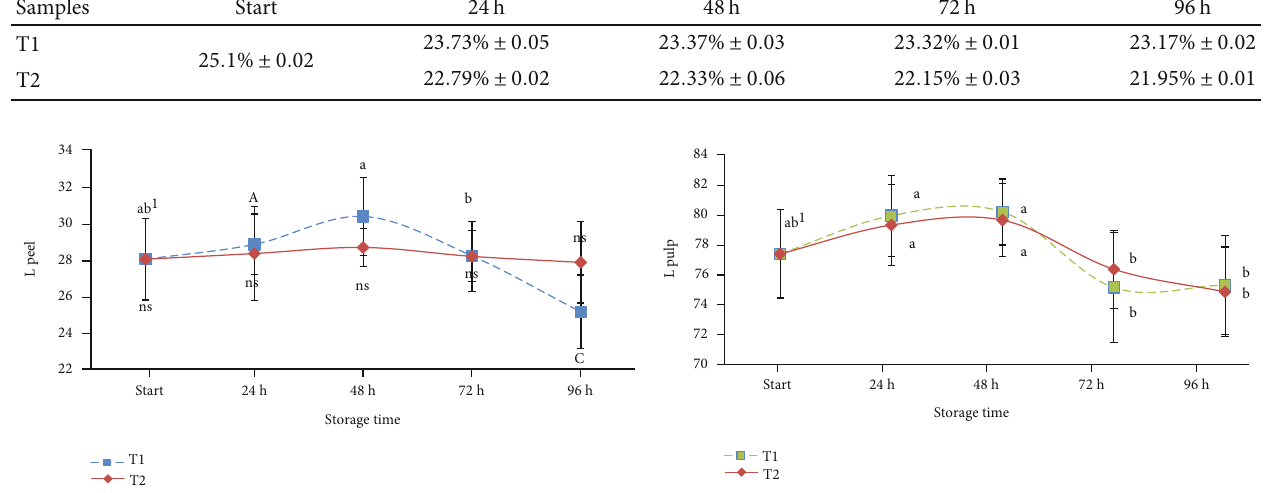
Figure 2: Evolution of the luminosity ( L ) colour parameter of stored cv. Hass (peel and pulp). Values followed by di ff erent letters are signi fi cantly di ff erent at P ≤ 0 : 05 (Tukey ’ s post hoc